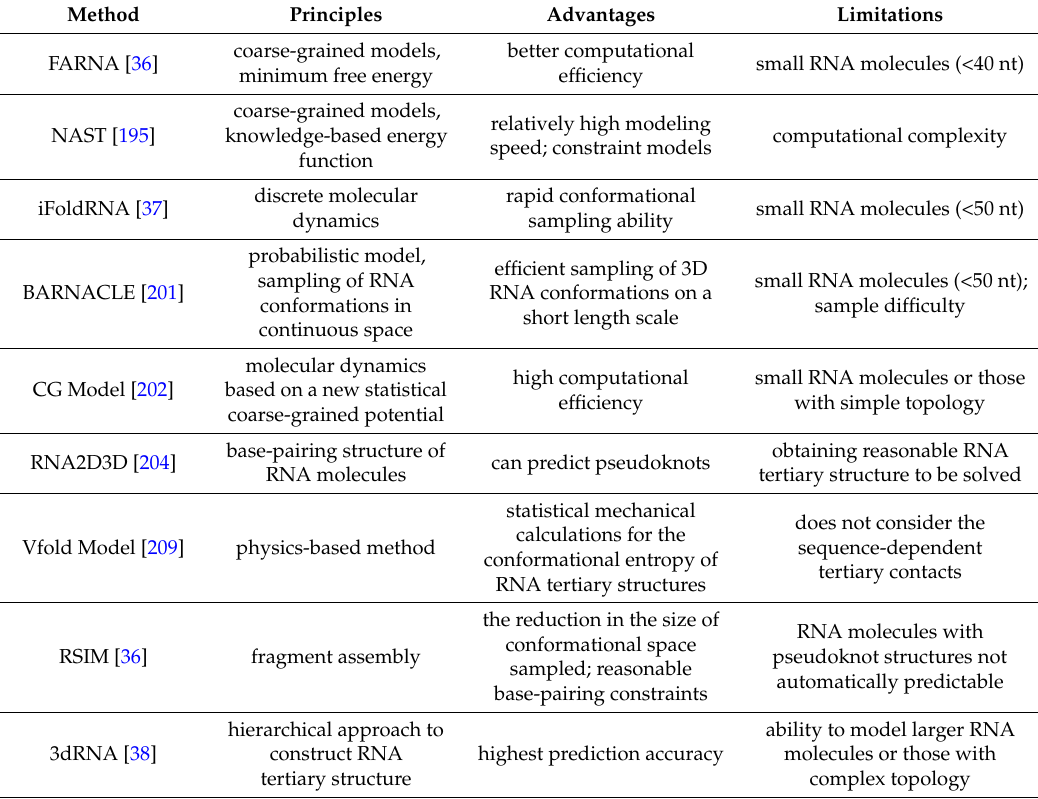
Table 2. Various methods for predicting RNA tertiary